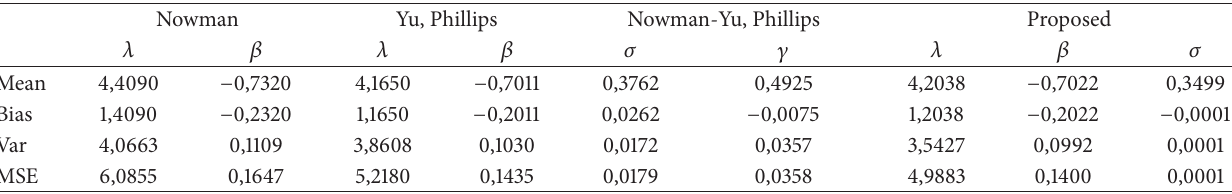
Table 4: Comparison of weekly data series with Nowman, Yu-Phillips, and proposed methods.